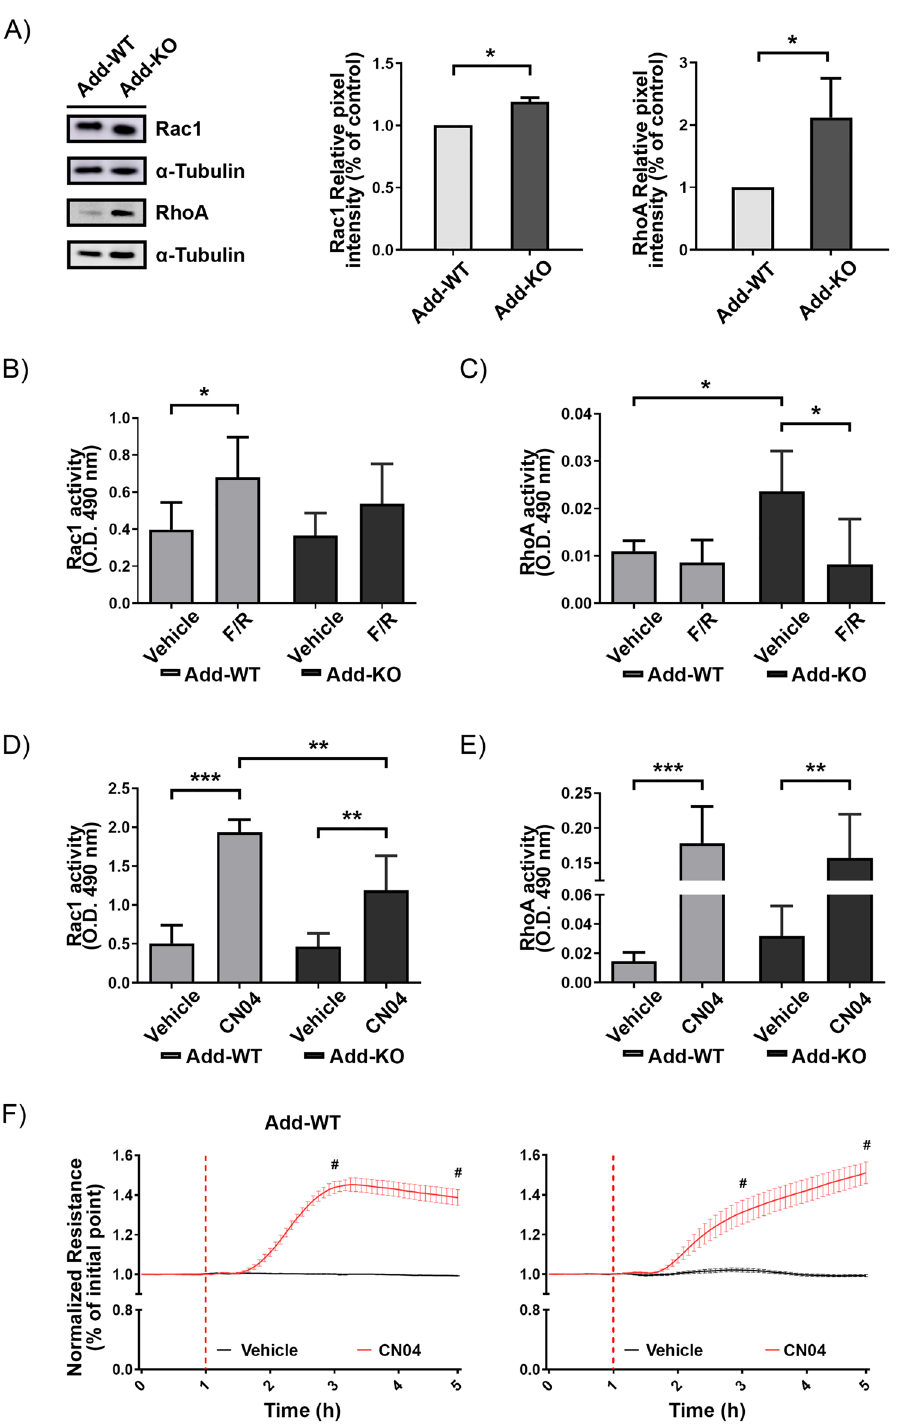
Figure 6. Protein expression, activation state of Rac1 and RhoA small GTPases and GTPase activity effects on TER. ( A ) Representative Western blot images for Rac1 and RhoA under basal conditions and respective pixel intensity quantifications presented as bar graphs. The data are normalized to the corresponding WT control (N = 4 per group). G-LISA small GTPases activation analysis of ( B ) Rac1 and ( C ) RhoA from confluent WT and Add-KO cells treated with Vehicle or F/R for 1 h. Activation status of ( D ) Rac1 and ( E ) RhoA from cells stimulated with Vehicle or CN04 for 2 h. Bar graphs show raw optical density (O.D.) measured with a wavelength of 490 nm (N = 4–7 per group). ( F ) TER measurements from confluent WT and Add-KO cell monolayers. Red-dashed line indicates the time of treatments. Data are normalized to the initial point of each corresponding group. “#” denotes statistically significant difference between Vehicle and CN04 treated groups (N = 3 per group). Data are represented as mean ± SEM; * p < 0.05; ** p < 0.01; *** p < 0.001, # p <